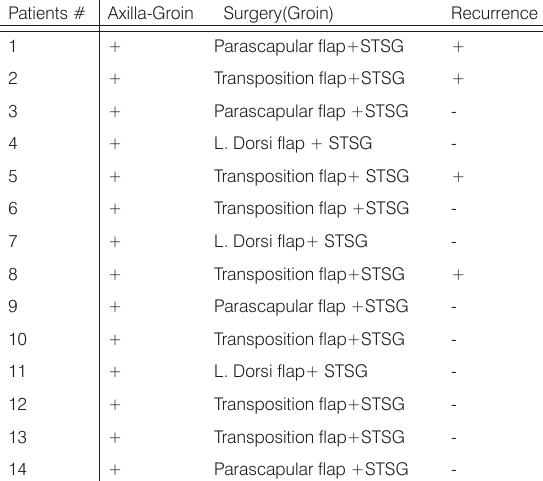
Table 1. Distribution of patients based on the involvement of anatomic areas.